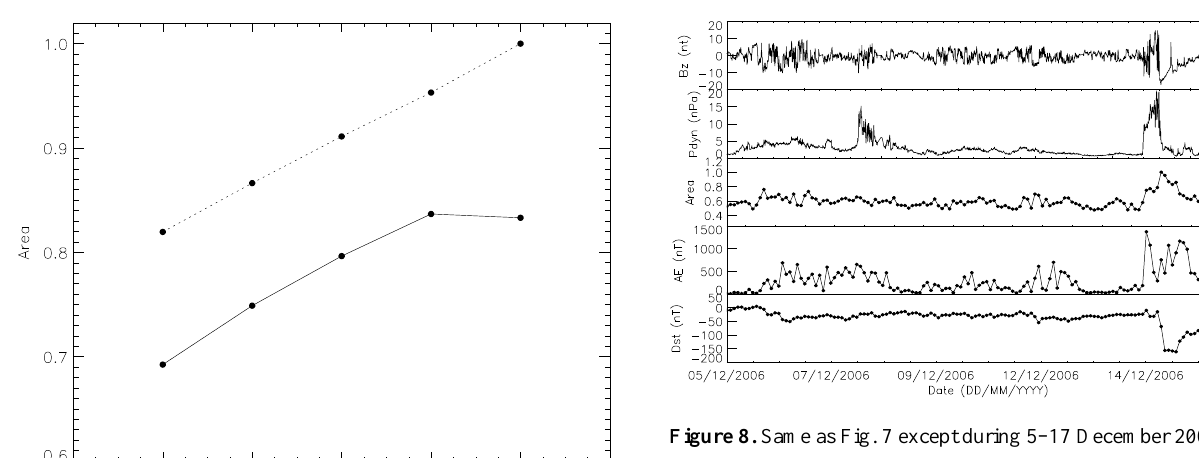
area (third panel), the AE index (fourth panel), and the Dst in- dex (bottom panel) for this period. The x coordinate of black the CRWs are calculated.